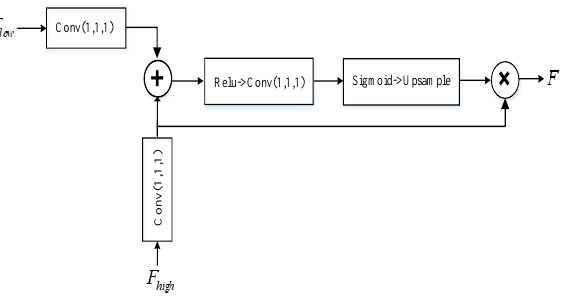
Figure 9. Attention fusion module. F low and F high are inputs, and F is the output.